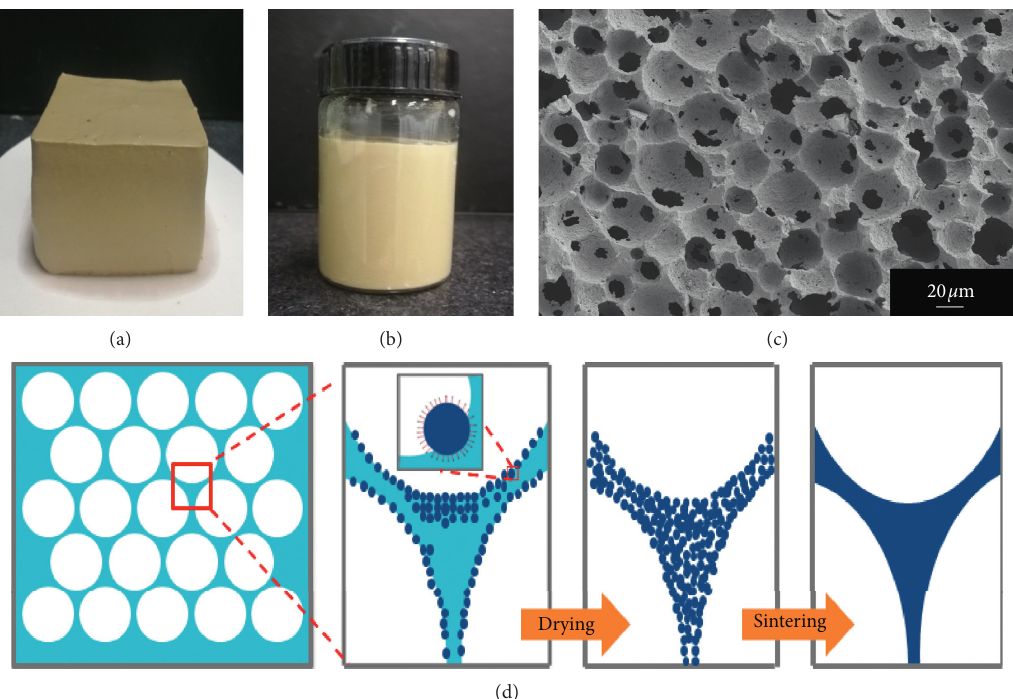
Figure 3: (a) Steel slag foam ceramics after demoulding. (b) Steel slag stabilized foams (the photo was taken 48h after frothing). (c) Microstructure of steel slag foam ceramics. (d) Schematic diagram of ceramic foams with spherical pore